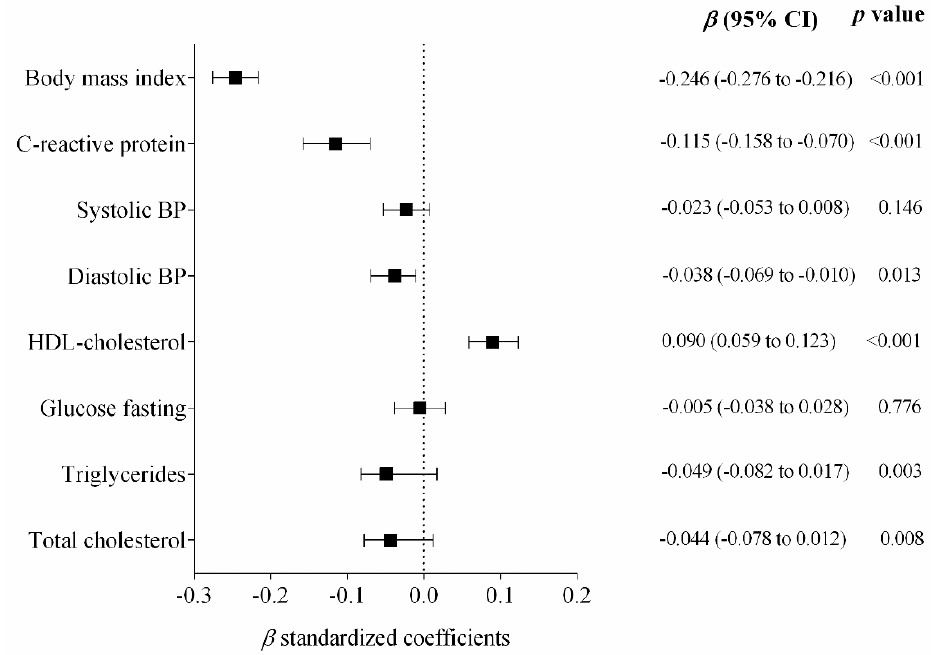
Figure 1. Standardized regression coefficients examining the association of cardiorespiratory fitness and cardiometabolic markers. Cardiorespiratory Fitness (Independent variable). Bars represent adjusted means and 95% confidence intervals, adjusted for age, sex, pubertal stage and country.